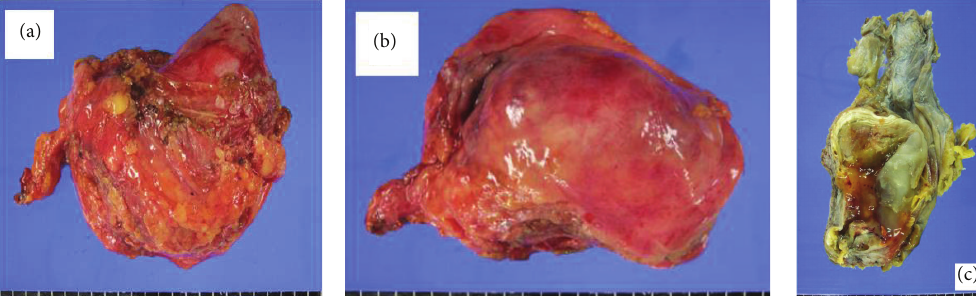
Figure 3: Surgical specimen shows a unilocular cyst without definite solid part, filled with gray tan to brownish thick mucus